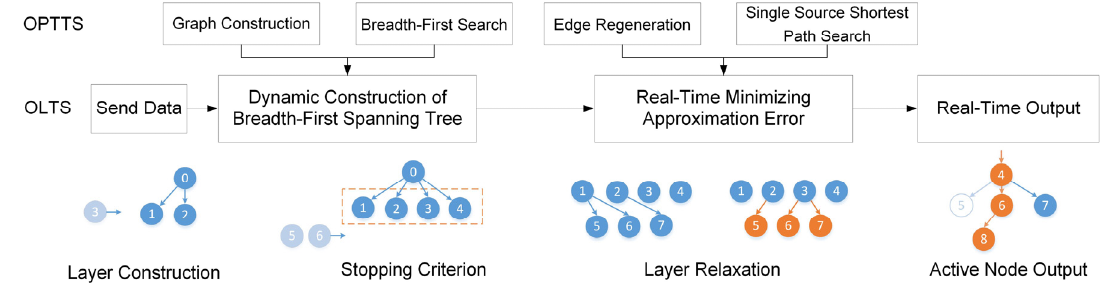
Figure 8. Flow chart of the OLTS.